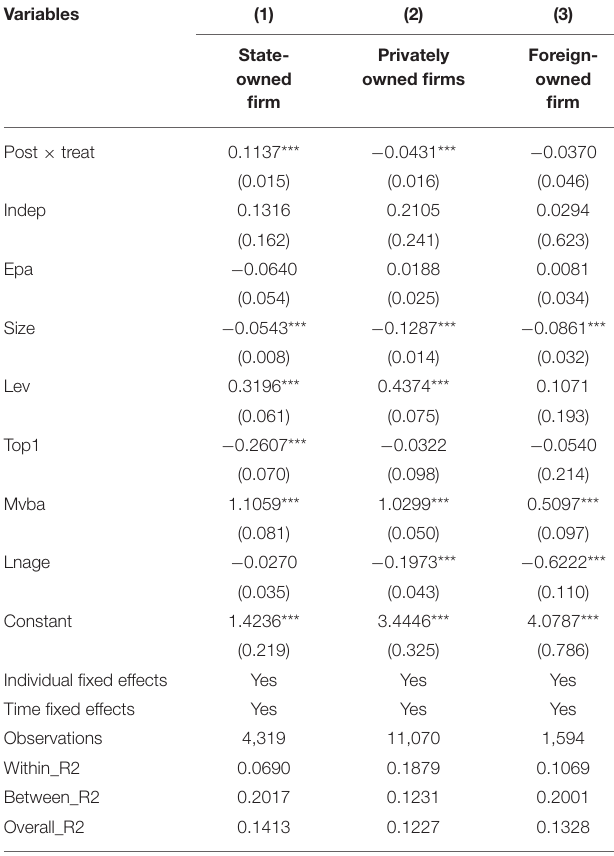
TABLE 5 | Regression results (the pharmaceutical sector vs. the non-pharmaceutical sector). Variables